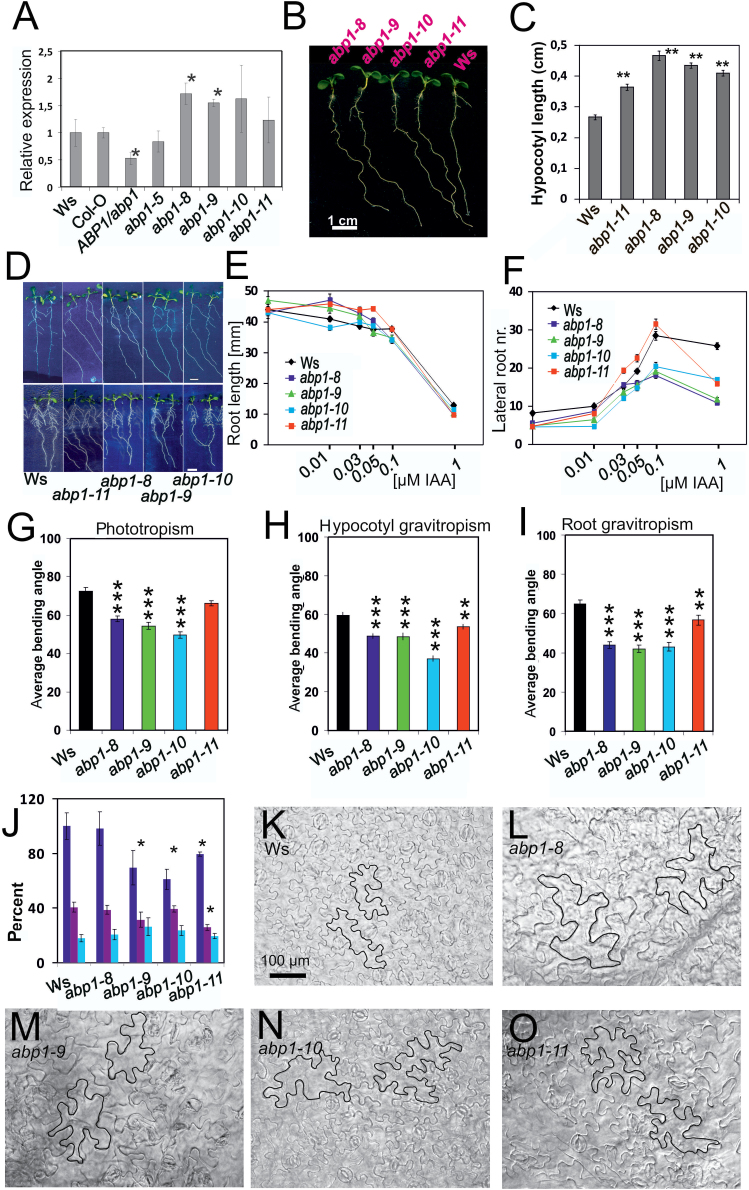
Developmental physiology of abp1 mutant seedlings. (A) Level of ABP1 transcript in abp1 mutants in comparison to the respective wild types ABP1 (abp1-5 is in Col-O, all others in Ws). Value for wt ABP1 is set as 1 (asterisk: different by P<0.05). (B) Representative light-grown seedlings (7 d; Ws, abp1 mutants). Bar=5mm. (C) Hypocotyl length of light-grown seedlings (14 d) (n=23–30; SEM, P<0.01). (D) Root development without auxin (upper row) and in the presence of 0.1 µM IAA (lower row) (n=30–39; SEM). (E) Auxin sensitivity of primary root length and (F) and lateral root number (n=30–39; SEM). Error bars are either visible or smaller than symbols. Non-overlapping symbols or error bars in E and F were significantly different from each other (P<0.01 or lower). (G) Delayed phototropic responses of hypocotyls of dark-grown (3 d) seedlings. Phototropism was induced by lateral blue light (10 µmol m–1 s–2) for 8h (SEM, n=70–130). (H) Delayed gravitropic responses in hypocotyls of 3-day-old dark-grown seedlings after 24h tilting by 90° (n=63–140). (I) Delayed gravitropic responses of roots of dark-grown seedlings (3 d) after 24h tilting by 90° (n=52–90). (G–I; average bending angles±SEM * P<0.05; ** P<0.01; *** P<0.001). (J) Acropetal auxin transport in roots of 4-day-old light-grown seedlings. Dark blue bars: 5–10mm from tip; purple bars: 10–15mm from tip; light blue bars: 15–20mm from tip. (n=40; *: P<0.05). (K–O) Epidermal pattern of primary leaves. (K) Wassilewskia wt; (L) abp1-8; (M) abp1-9; (N) abp1-10; (O) abp1-11. In each photo two cells are outlined for comparison. Bars=100µm. Cell areas and lobe numbers of epidermis cells are presented in Supplementary Fig. S2.